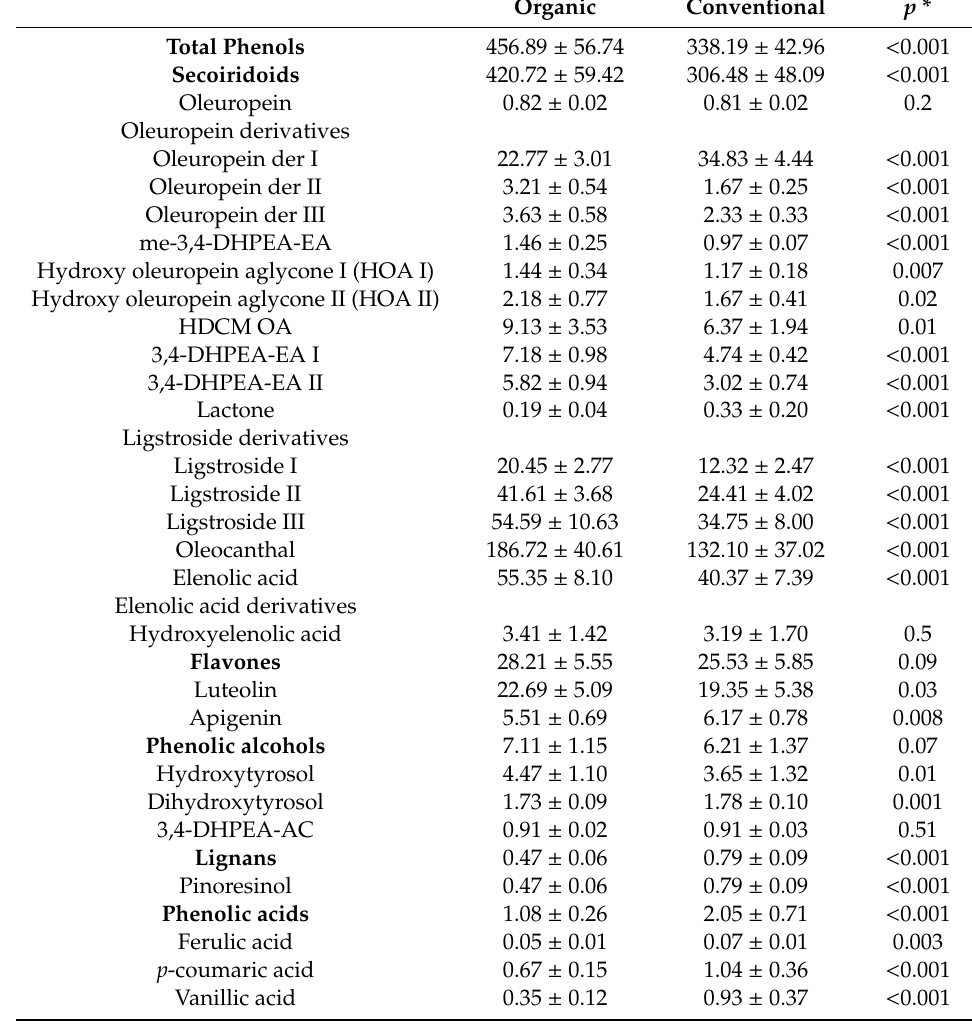
Table 1. Phenolic compound contents (mg·kg − 1 ) of conventional and organic EVOO made from Hojiblanca olives. * p -values of U Mann–Whitney test .